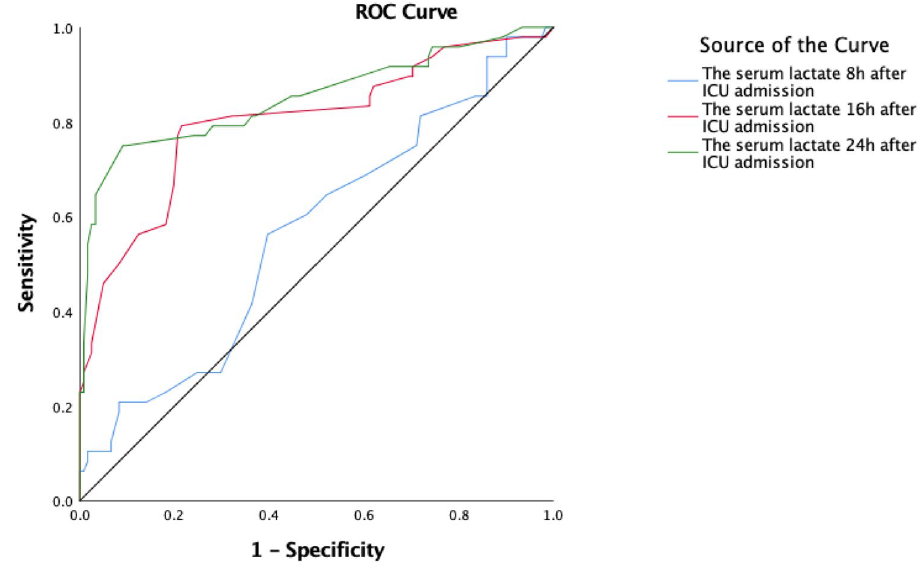
Figure 3. Receiver Operating Characteristic (ROC) Curve of the Serum Lactate to ΔGCS 24h .